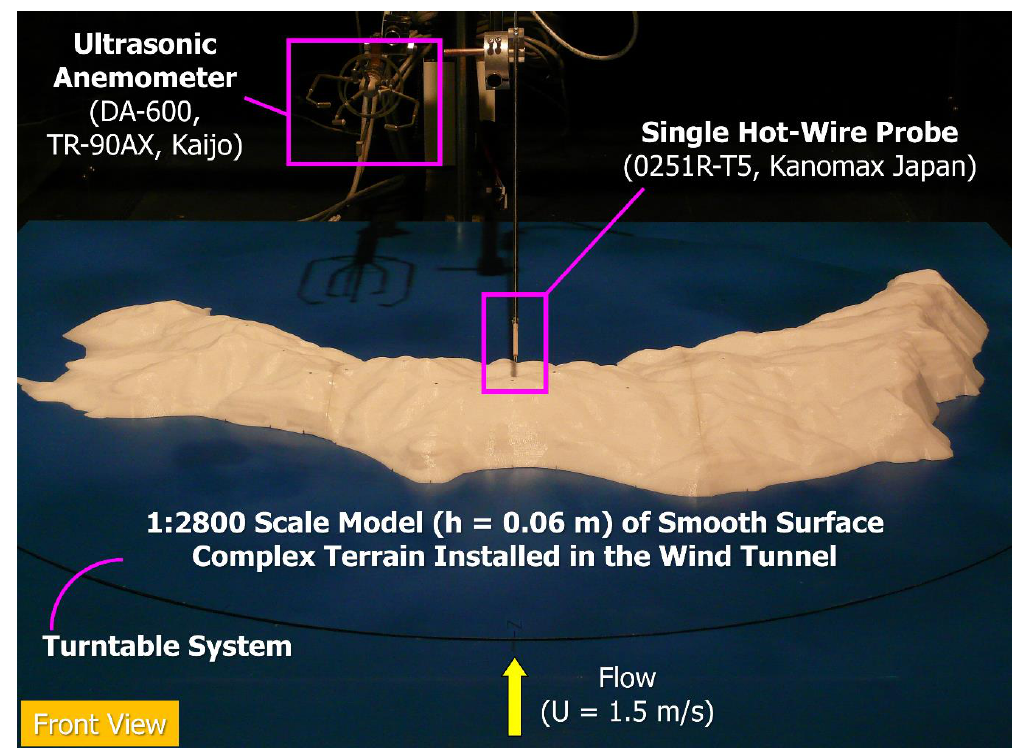
Figure 18. Complex three-dimensional terrain model without irregularities installed in the wind tunnel.